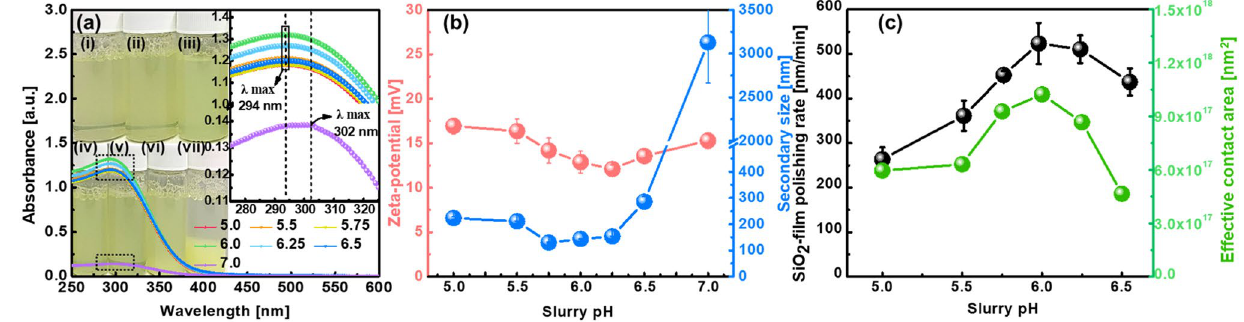
Figure 5. CMP slurry characteristics and CMP performance dependent on pH values of slurries, including super-fine (~ 2 nm in size) Ce(OH) 4 wet ceria abrasives. ( a ) Peak absorption wavelength and absorbance, ( b ) abrasive zeta potential and secondary abrasives size, and ( c ) SiO 2 -film polishing rate and effective contact area between abrasives and SiO 2 -film surface. In ( a ), the CMP slurries in beakers (i), (ii), (iii), (iv), (v), and (vi) were produced at pH values of 5.0, 5.25, 5.5, 5.75, 6.0, 6.5, and 7.0, respectively, following a synthesis. As previously mentioned, super-fine wet ceria abrasives for all CMP slurries were synthesized at a termination pH of